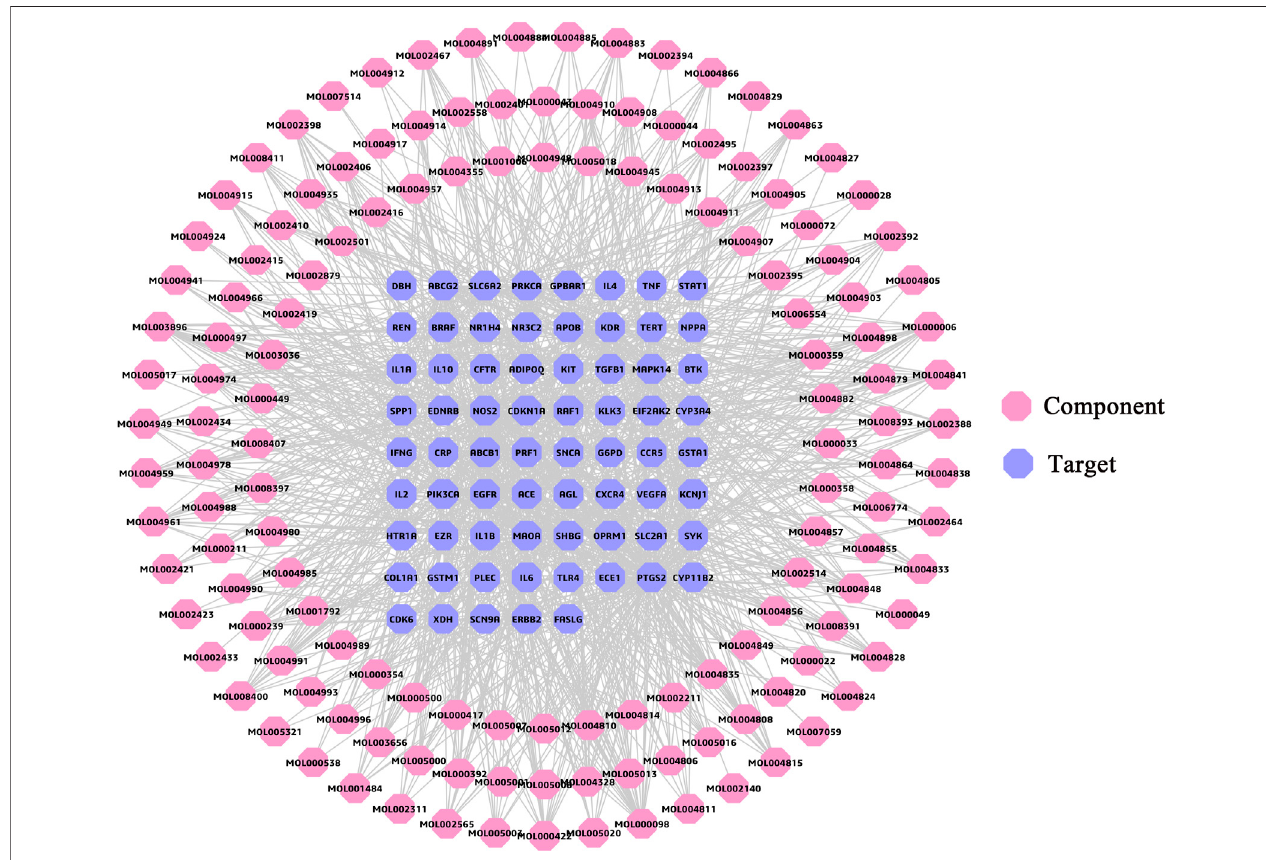
FIGURE 3 | Component – target network. The pink regular octagon represents compound, and the lilac regular octagon represents the target.